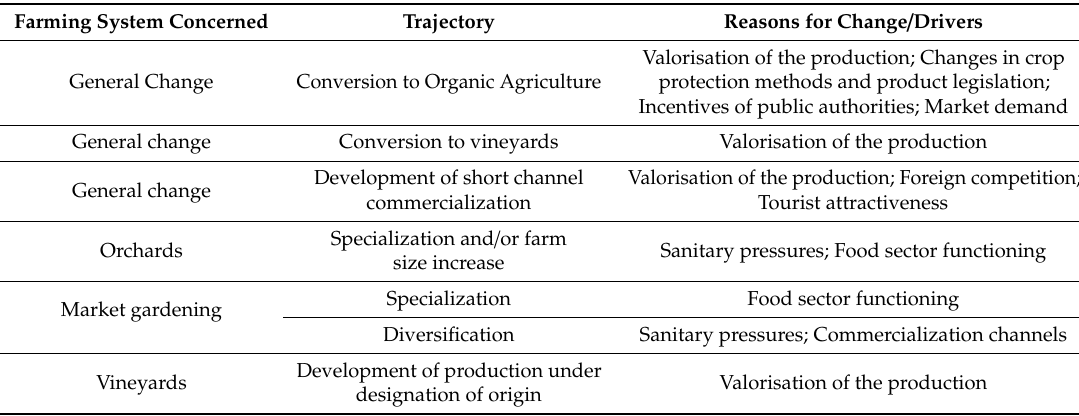
Table 2. Farming system